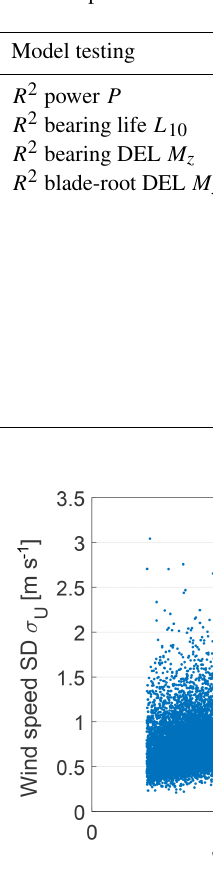
Table 2. Hyperparameter of ANN used as surrogate model and accuracy of the model predictions on the test set.